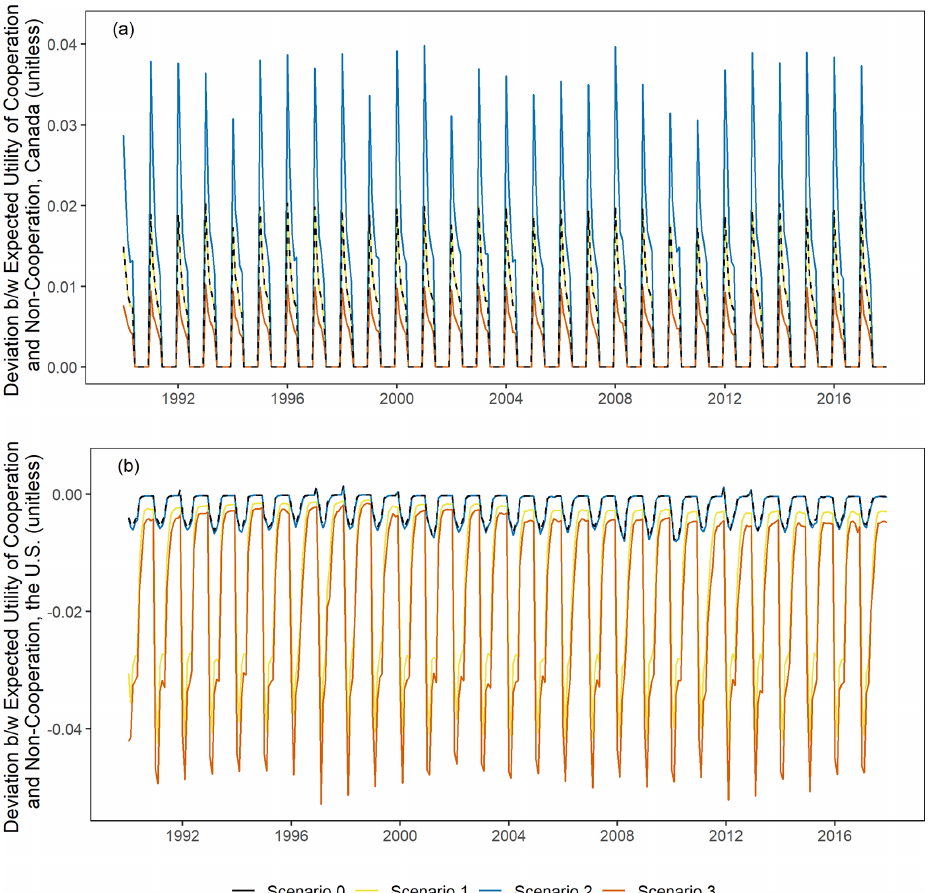
Figure 9. The differences between the expected utility of cooperation and no cooperation from each country according to different scenarios for (a) Canada and (b) the United